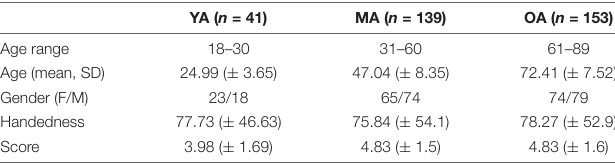
TABLE 1 | Participants’ characteristics and scores on the proverb test. YA ( n = 41) MA ( n =